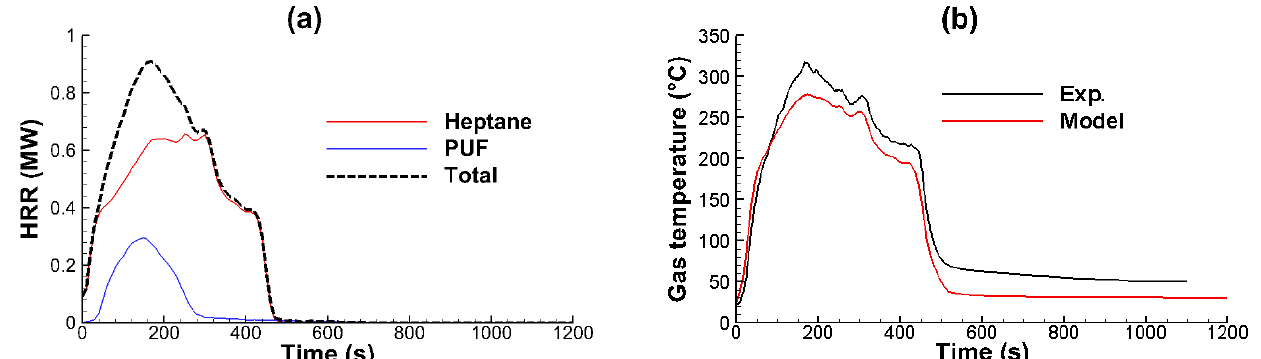
Figure 16. Test 8: ( a ) individual and total HRRs, ( b ) average gas temperature, ( c ) average wall temperatures, ( d ) volume fractions of O 2 and CO 2 in the exhausted gases, and ( e ) smoke layer interface height.